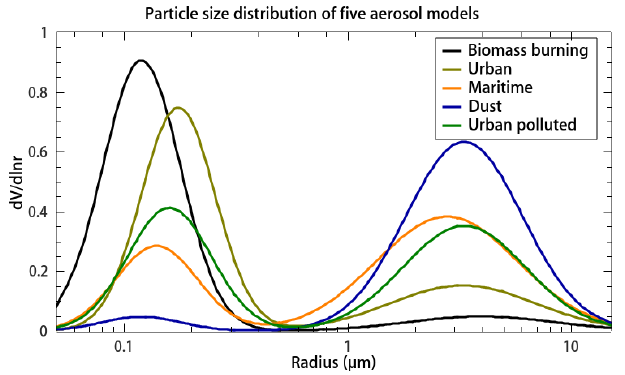
Figure 3. The particle size distribution of five aerosol compo- nents listed in Table 4. This simplified aerosol component-based GRASP/Models kernel is used for the AirHARP AOD inversion over the collocated AERONET pixels during the ACEPOL 2017